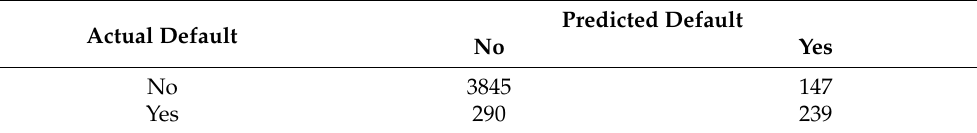
Table 8. Confusion matrix with C5.0 model with added